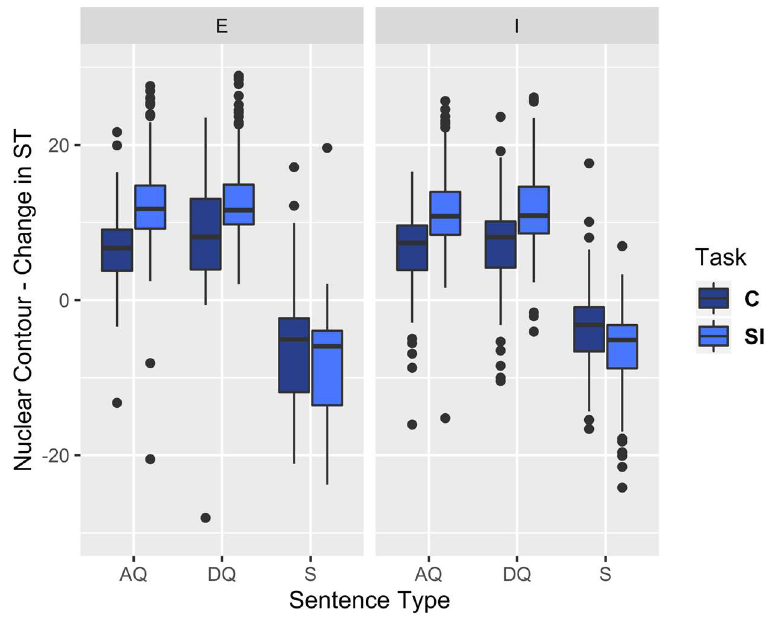
Figure 10. Boxplots displaying the pitch change (in semitones) over the nuclear contour in both tasks. Results organized by group.